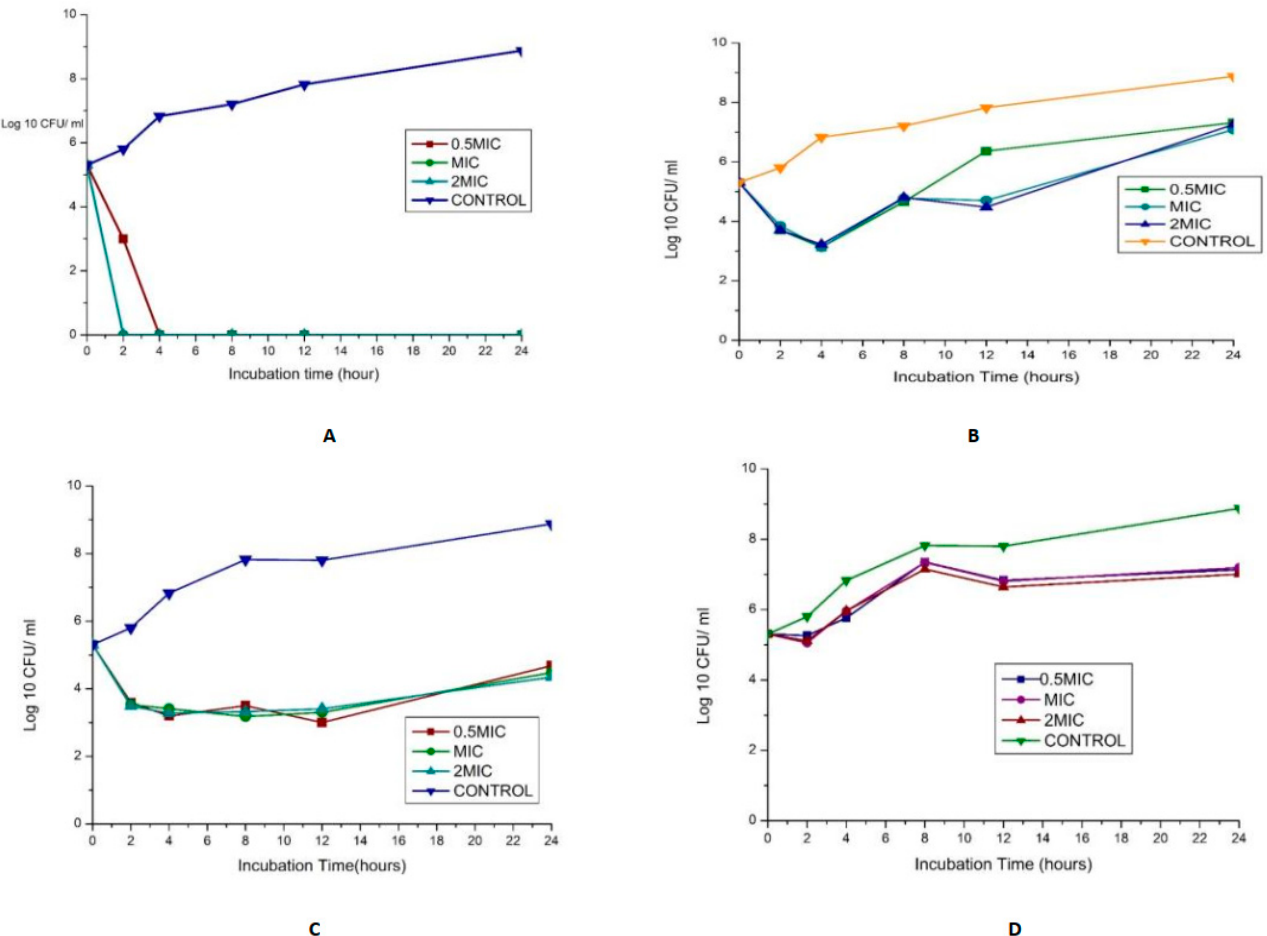
Figure 4. ( A )Time-kill assay of a combination of gentamicin (4 µ g/mL) with Vancomycin (128 µ g/mL) antibiotics against Enterococcus faecium_ bactericidal ( B ): Time-kill assay of the combination of gen- tamicin (4 µ g/mL) with ampicillin (8 µ g/mL) antibiotics against Enterococcus faecium _ bacteriostatic ( C ): Time-kill assay of the combination of gentamicin (4 µ g/mL) with Vancomycin (256 µ g/mL) antibiotics against Enterococcus faecalis- bacteriostati c ( D ): Time-kill assay of the combination of ciprofloxacin (1 µg/mL) with Ampicillin (16 µg/mL) antibiotics against Enterococcus faecalis- bac- teriostatic.